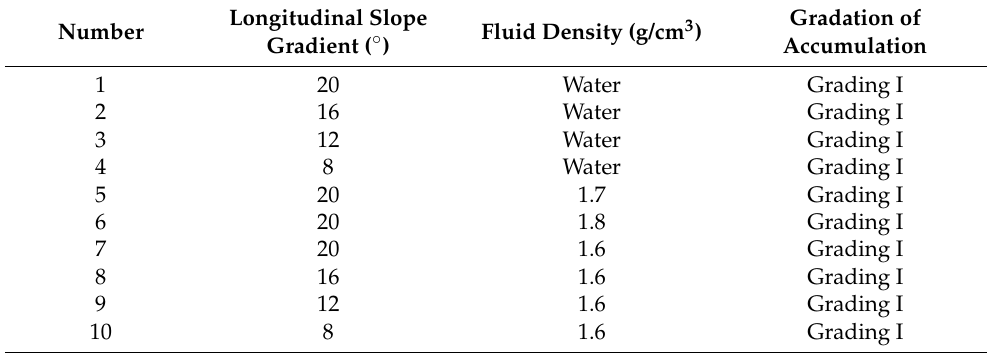
Table 3. Experimental